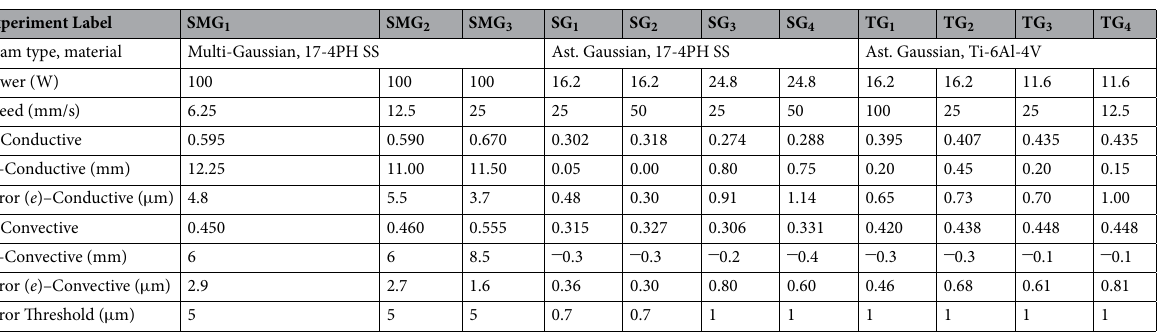
Table 1. Conditions and results for each one of the 11 experiments. Experiments within group SG or within group TG have been conducted on the surface of the same substrate, and thus should have very similar sample surface location z S . The results here include the optimal values of α and z S , i.e., those that minimize the error between the computational and experimental curves for each one of the two models. Two dimensional melt pool traces were deemed similar enough to the experimental one for errors below the